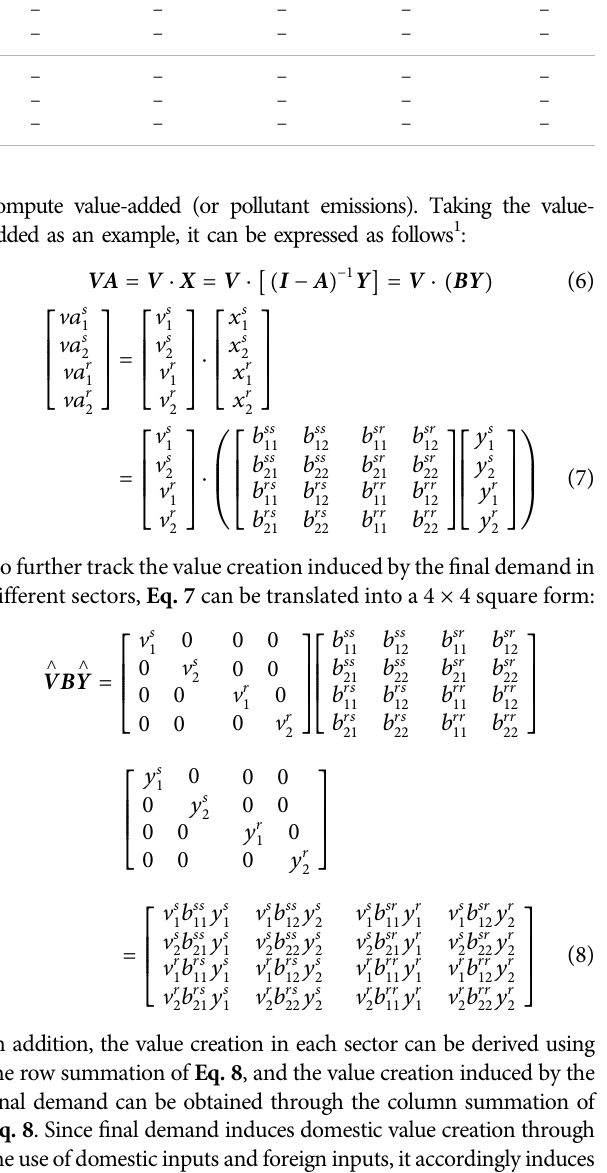
1 The dot product between the two matrices here represents the corresponding elements of the two for